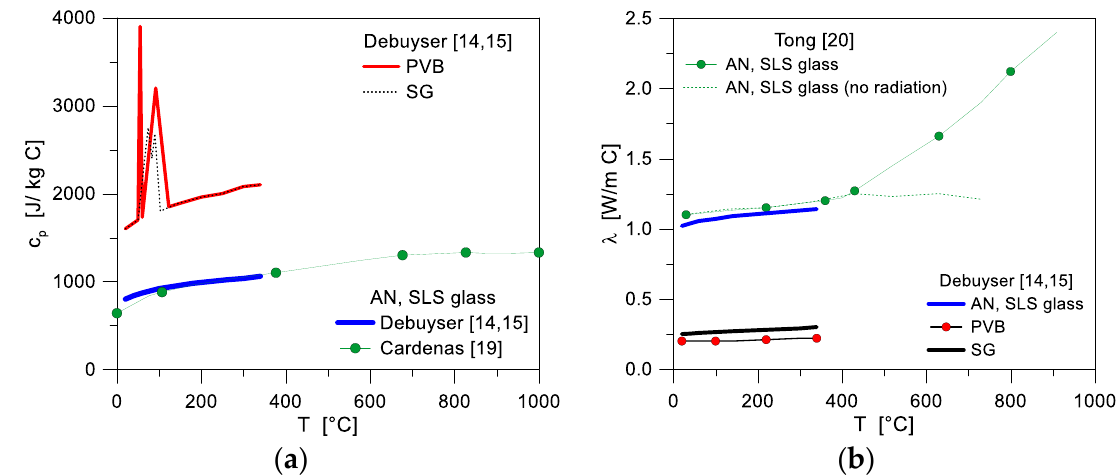
Figure 2. Thermal properties of glass and common interlayers, as a function of temperature. ( a ) specific heat c p and ( b ) conductivity λ (figures adapted from [7]).